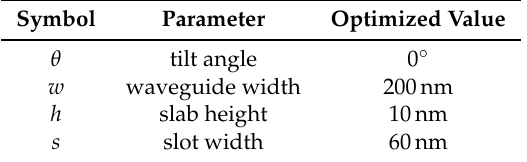
Table 2. Optimized slot-waveguide parameters in terms of field confinement